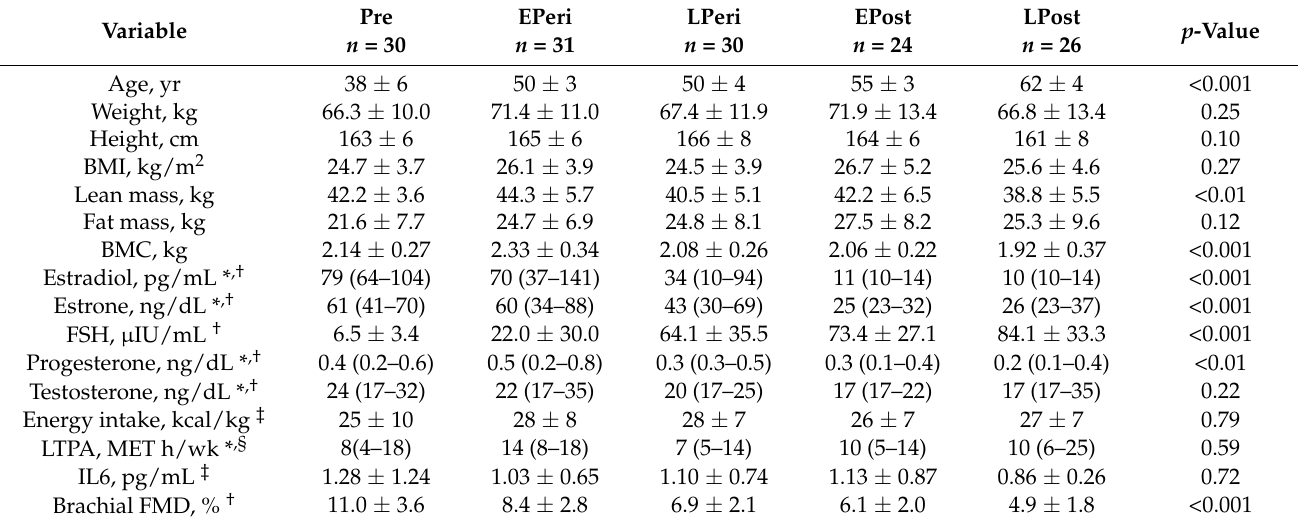
Table 1. Subject characteristics.